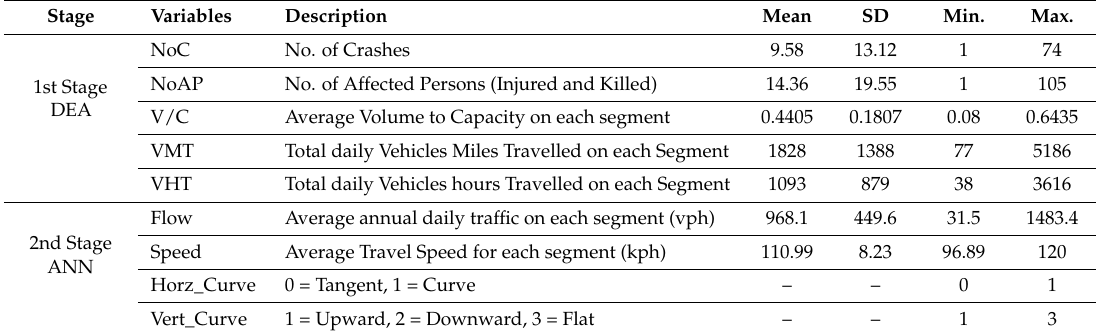
Table 1. Description Statistics of the